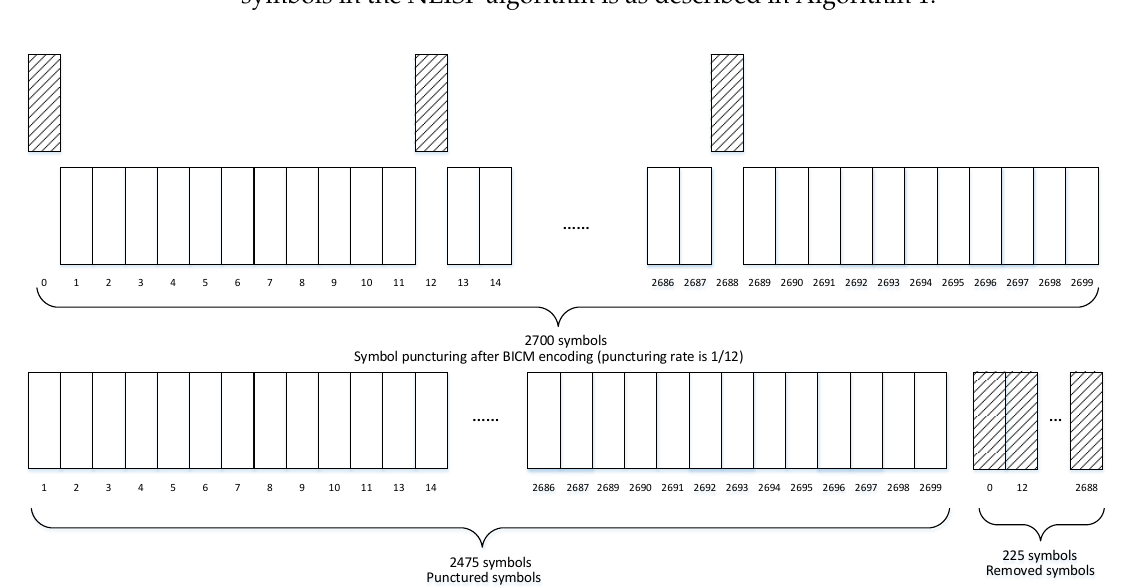
Figure 5. The schematic diagram of the equal interval symbol puncturing (EISP) after bit-interleaved coded modulation (BICM) encoding in the LDM-Ex-FDM scheme.